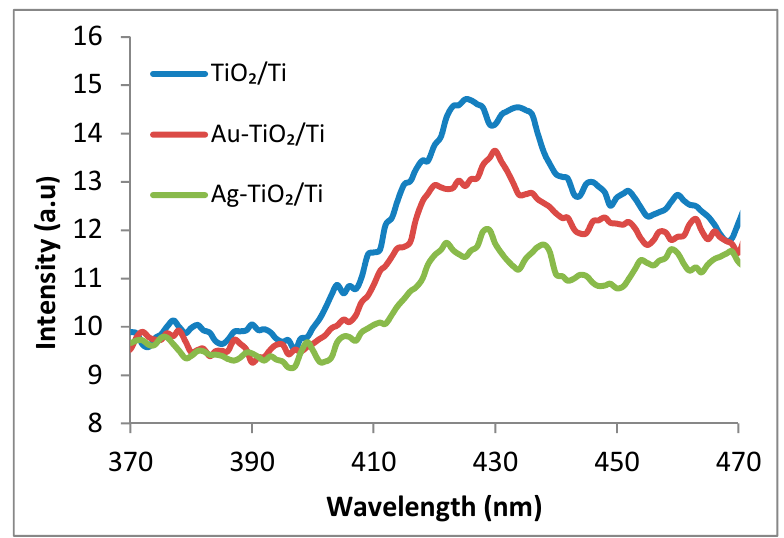
Figure 6. Photoluminescence spectra of TiO 2 /Ti, Au–TiO 2 /Ti and Ag–TiO 2 /Ti samples registered for λ exc = 270 nm.